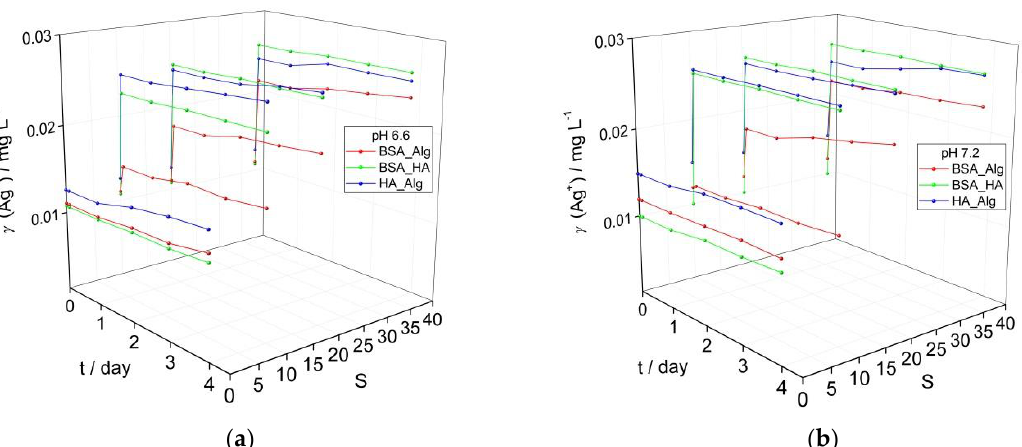
Figure 2. Temporal change in calculated Ag + ion concentration based on intensity of the SPR peak maximum for AgNP coated with combinations of NOM (BSA, HA and Alg concentrations of 10, 10 and 1 mg L −1 , respectively) at ( a ) pH 6.6, and ( b ) pH 7.2 as a function of salinity (S·0-38).